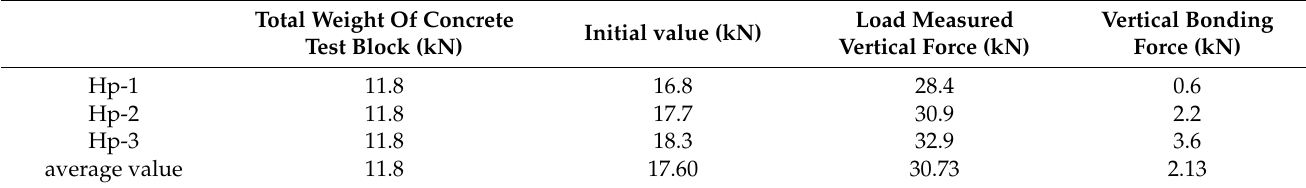
Figure 17. Vertical jack loading curve of Hp specimen. Table 6. The vertical force of the test piece when the contact surface is paper base asphalt felt.